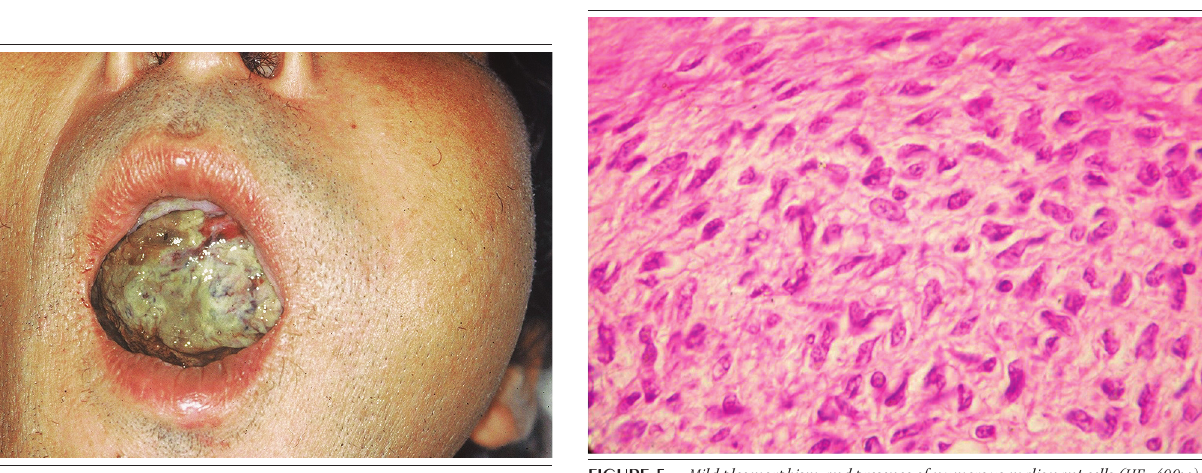
figurE 2 − Intraoral view of the primary lesion showing an exophytic and ulcerated appearance